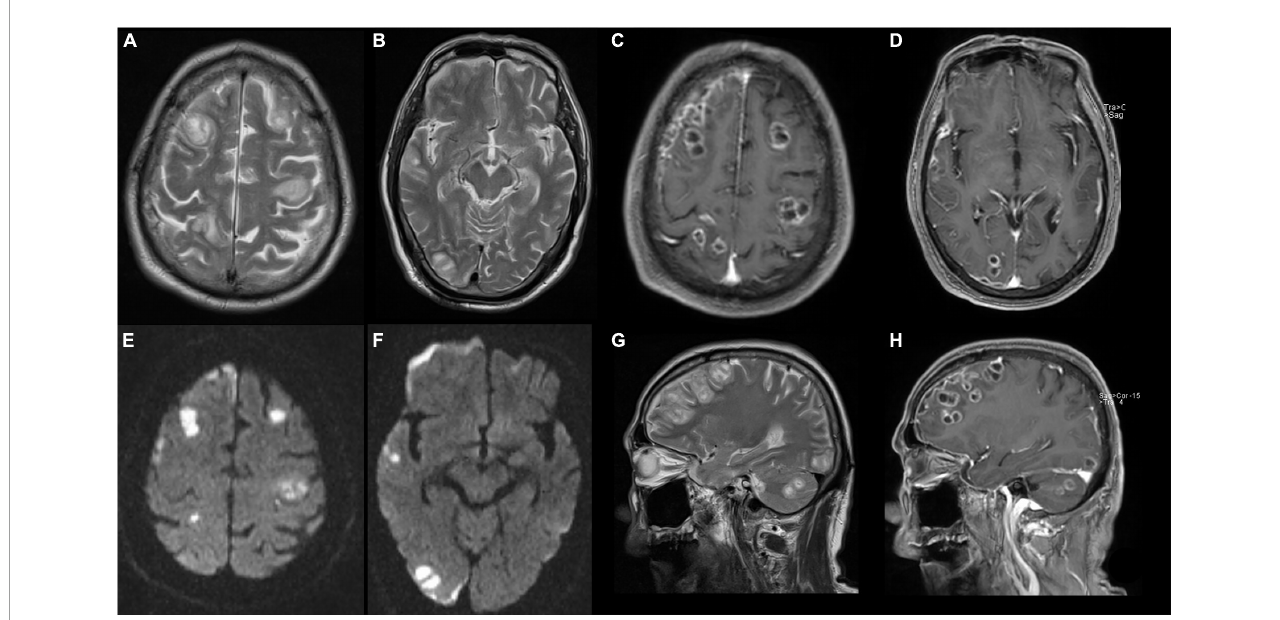
FIGURE3 Magnetic resonance image (MRI) of brain shows abscesses in bilateral frontal lobe, right temporo-parieto-occipital lobe, and right cerebellar hemisphere with ring contrast enhancement and perilesional edema. (A,B,G) T2-weighted imaging. (C,D,H) T2 contrast-enhancement imaging. (E,F) Diffusion-weighted